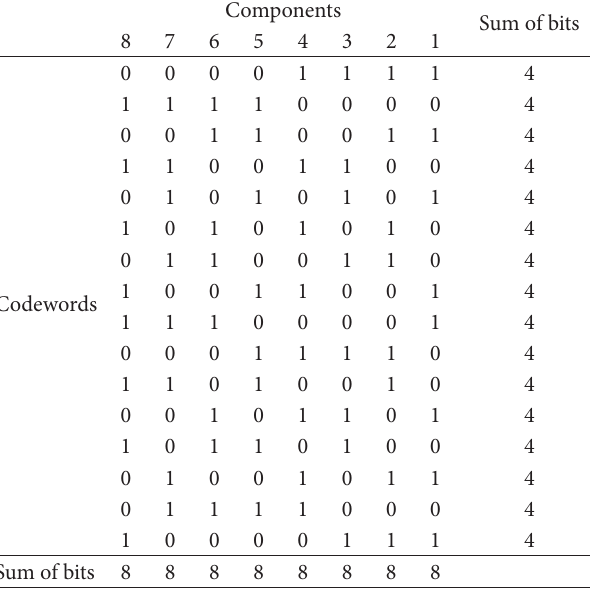
Table 1: Horizontally and vertically balanced code with length 8 and 16